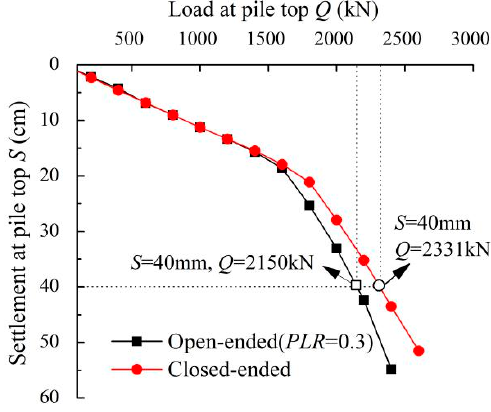
Figure 12. Curve of load-displacement at the pile top.